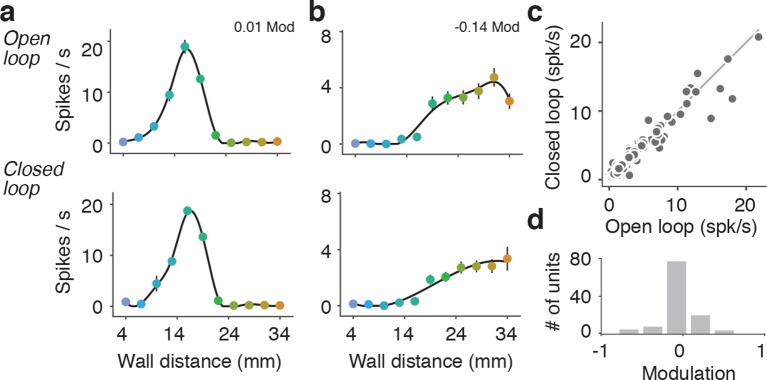
Comparison of open-loop and closed-loop tuning curves.(a) Open-loop and closed-loop tuning curves for a regular spiking unit that gets activated by the wall. (b) Open-loop and closed-loop tuning curves for a unit that gets suppressed by the wall. (c) Scatter of the mean spiking rate of open-loop and closed-loop tuning curves. (d) Histogram of open vs. closed-loop modulation index which is the difference in open-loop and closed-loop spiking rates divided by the sum of open-loop and closed-loop spiking rates. Units that respond more during open loop trials have positive modulation, units that respond more during closed loop trials have negative modulation, and units that responded equally to both open and closed loop trials have a modulation of 0.